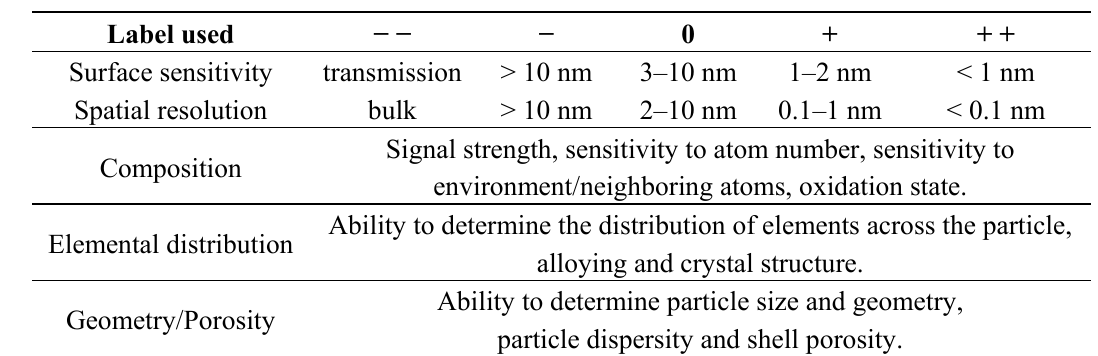
Table 1. Criteria used for the critical assessment of available